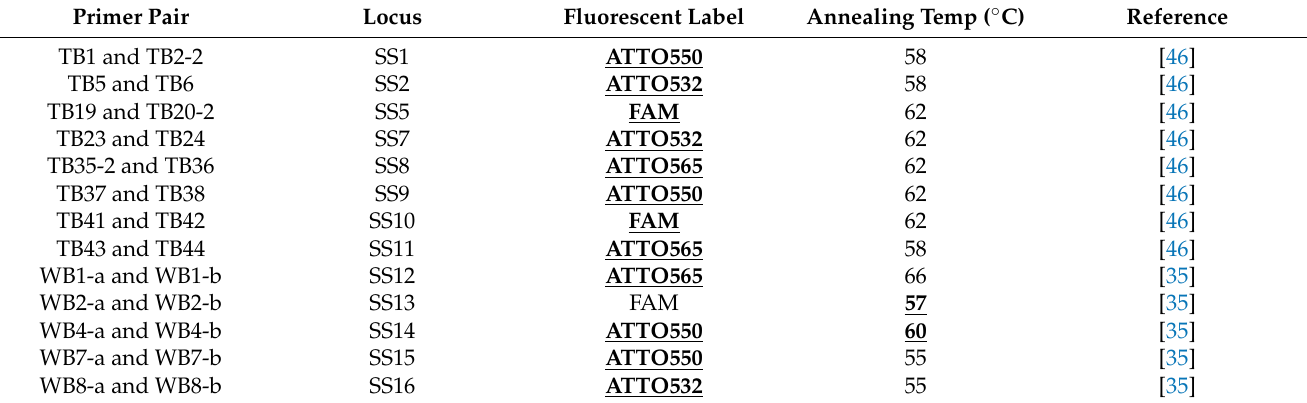
Table 1. Thirteen D. sapinea microsatellite markers with fluorescent labels and annealing temperatures. Fluorescent labels were attached to the forward primers. Deviations from the reference labels and annealing temperatures are underlined and highlighted in